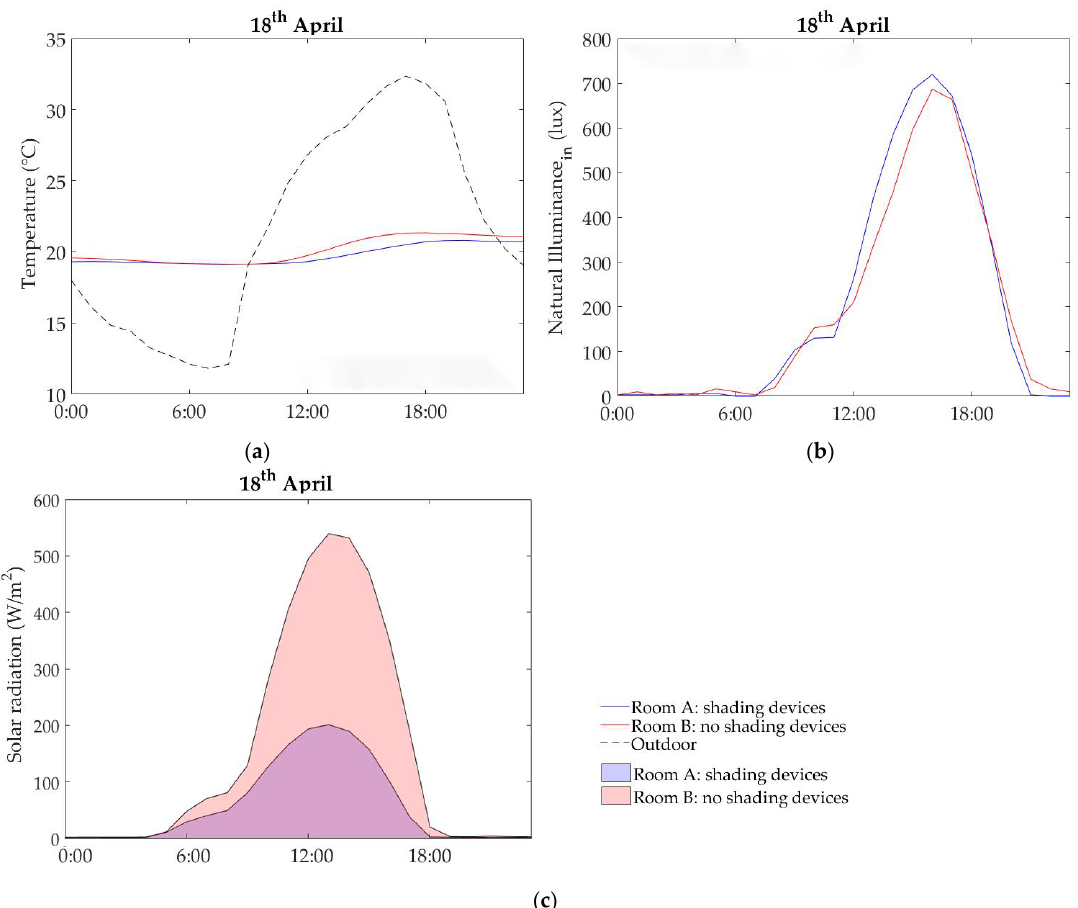
Figure 7. Values recorded during 18th April 2018 (mid-season). Unoccupied and free-running conditions : ( a ) indoor operative temperatures; ( b ) natural illuminance; and ( c ) solar radiation levels.